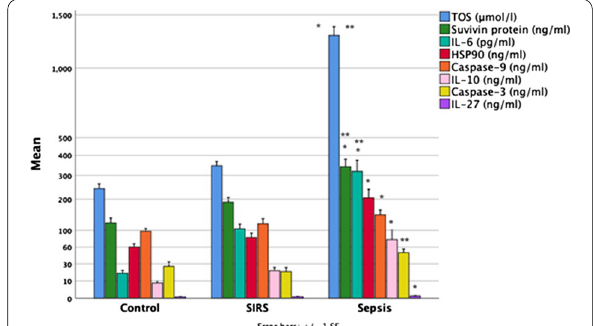
Fig. 1. Elevated levels of apoptotic (caspase-3, -9), anti-apoptotic (survivin), heat-shock response molecules (HSP90) or of inflamma- tory markers (IL-6, IL-10, IL-27) in sepsis, compared to non-infec- tious SIRS and to healthy controls Bars represent means, error bars 1 Error bars. Stars indicate signifi- ± cantly higher levels in sepsis (p < 0.05) compared to healthy controls* or SIRS** Conclusion. The sepsis-induced increased apoptotic (caspases), anti- apoptotic (survivin), inflammatory and oxidative stress response is related to outcome in adult ICU